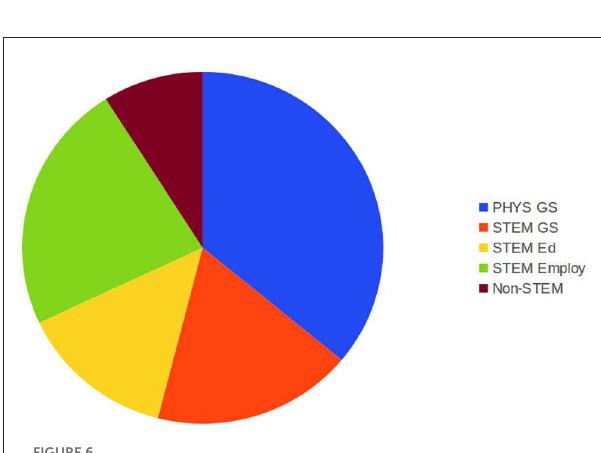
FIGURE6 Post-graduate career trajectory decisions for 22 women degree recipients from the Physics Group in the years 2013–2021. Decisions were categorized 1-year after graduation. All but two of the graduates were retained within STEM advancement positions. Legend categories are discussed in the text (Section